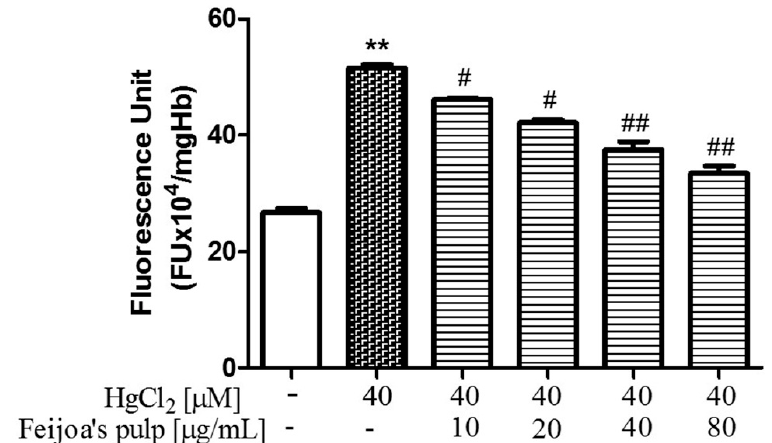
Figure 4. Feijoa pulp extract protects against Hg-induced ROS production in RBC. Cells were treated with 40 µ M HgCl 2 for 4 h in the presence of increasing concentrations of extract. ROS production was determined by fluorescence unit means of the DCF probe. Data are the means ± SEM ( n = 9). Statistical significance was calculated with one-way ANOVA followed by Tukey’s test. ** ( p < 0.05) indicates a significant di ff erence from cells lacking HgCl 2 treatment. # ( p < 0.05) and ## ( p < 0.01) indicate significant di ff erences from cells lacking Feijoa extract treatment.